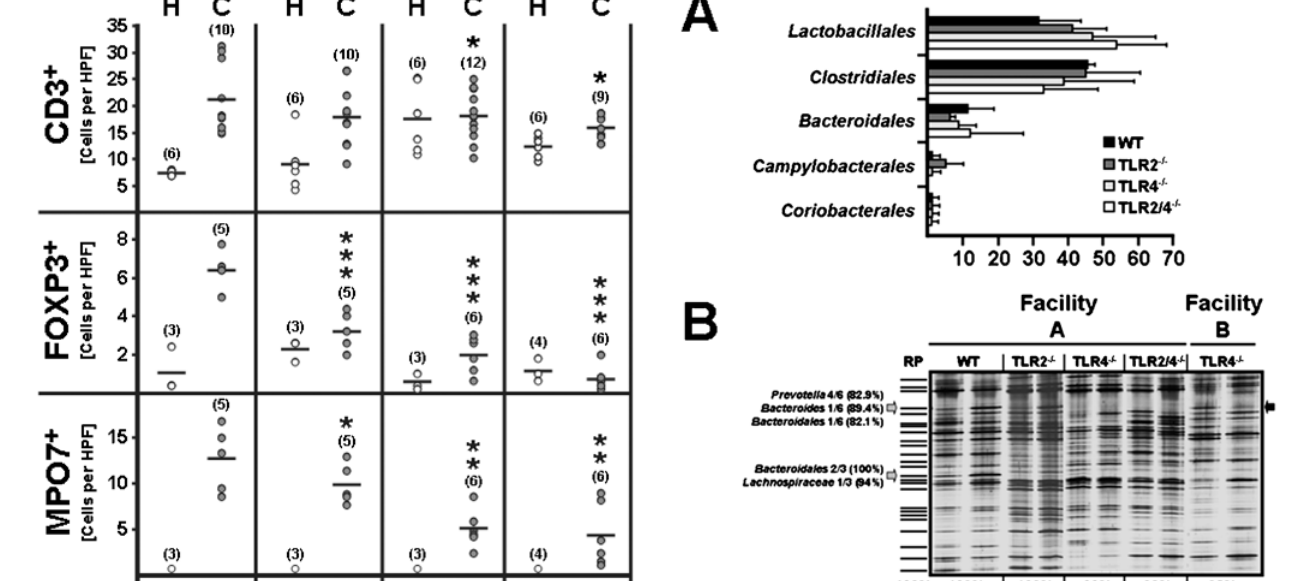
band was detected in one of the TLR4 -/- animals (Figure 3B) provided strong evidence that these differences are most likely caused by interindividual variability.